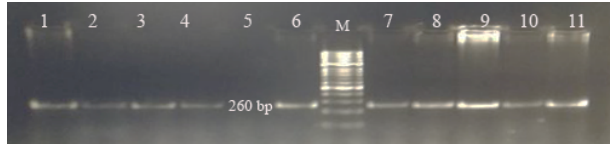
Figure 1. Agarose gel appearance of Pit-1 -PCR products under UV (M: marker, Pit-1 : 260bp).